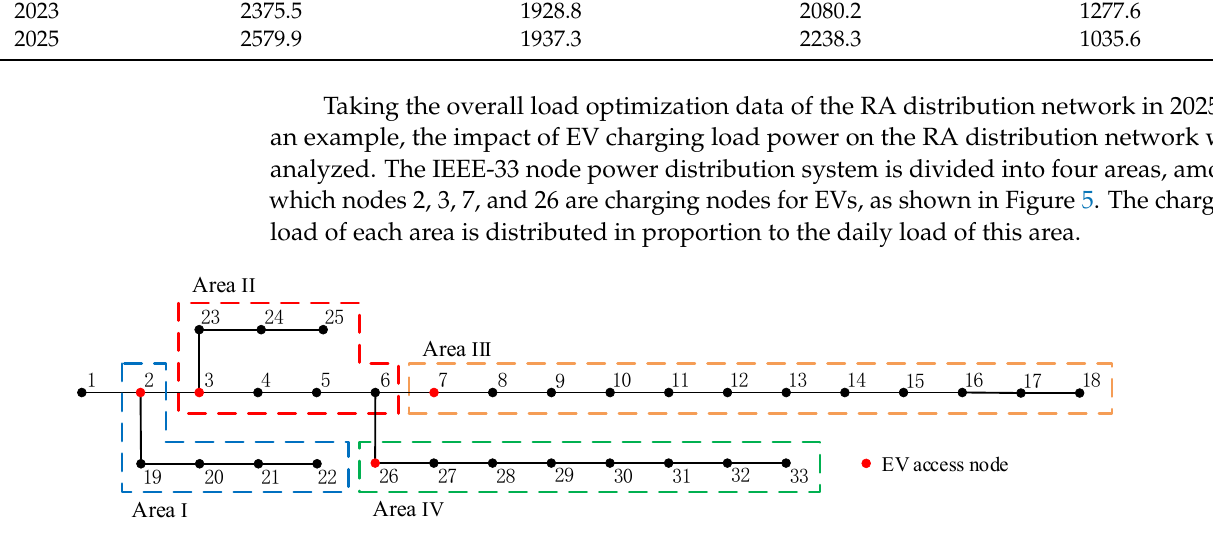
Figure 5. Area division of IEEE-33 node distribution network.